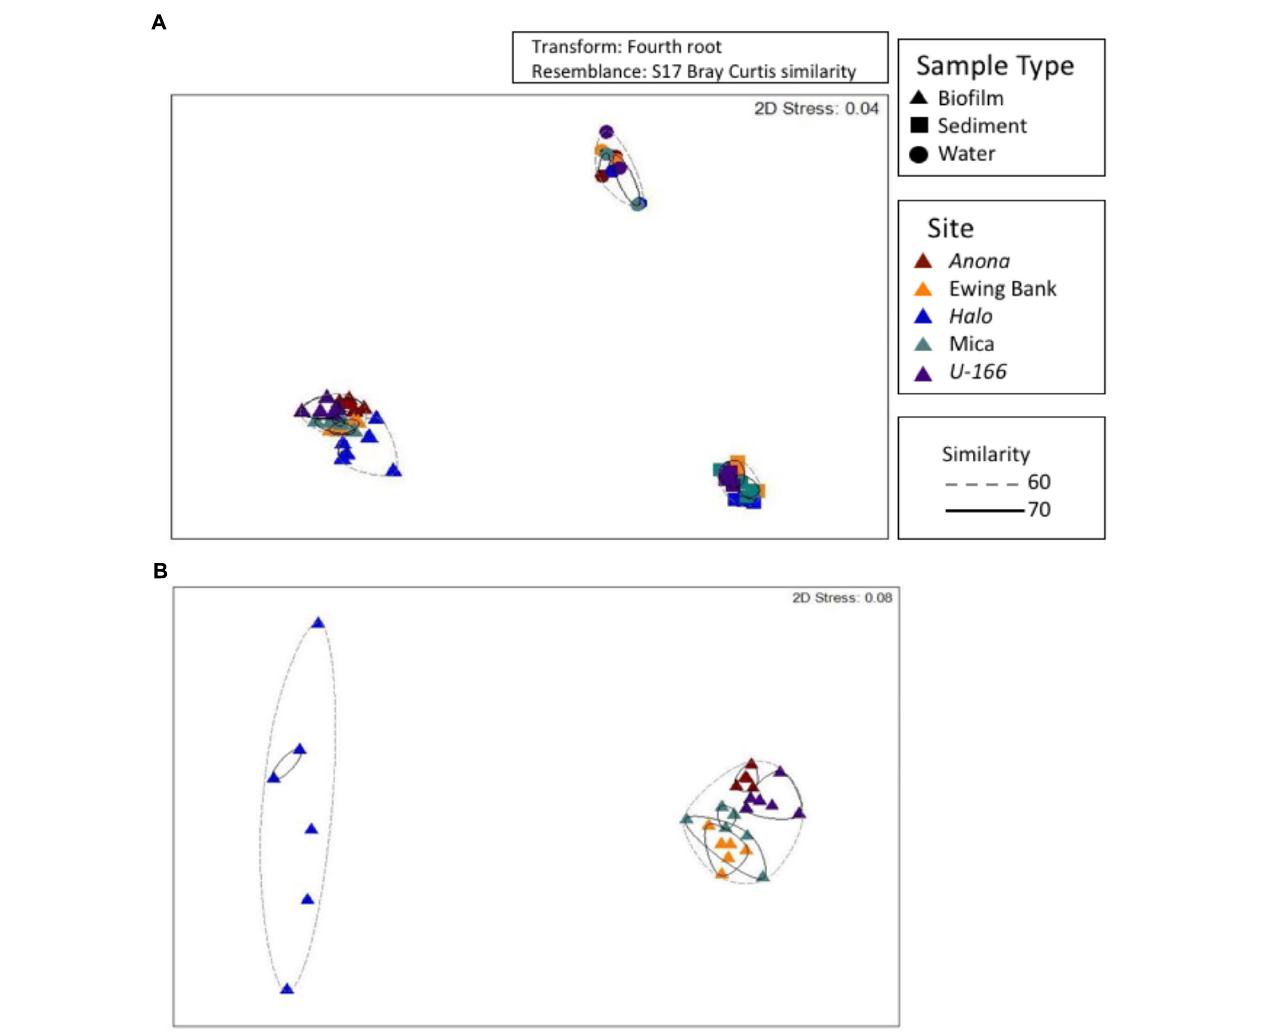
FIGURE 5 | Non-metric multidimensional scaling analysis of bacterial communities at all sites and in all sample types (A) . A subset of biofilm samples from BMPs (B) . Hierarchical clustering used to obtain similarity dendrograms, based on group average linkage are projected on the plot as